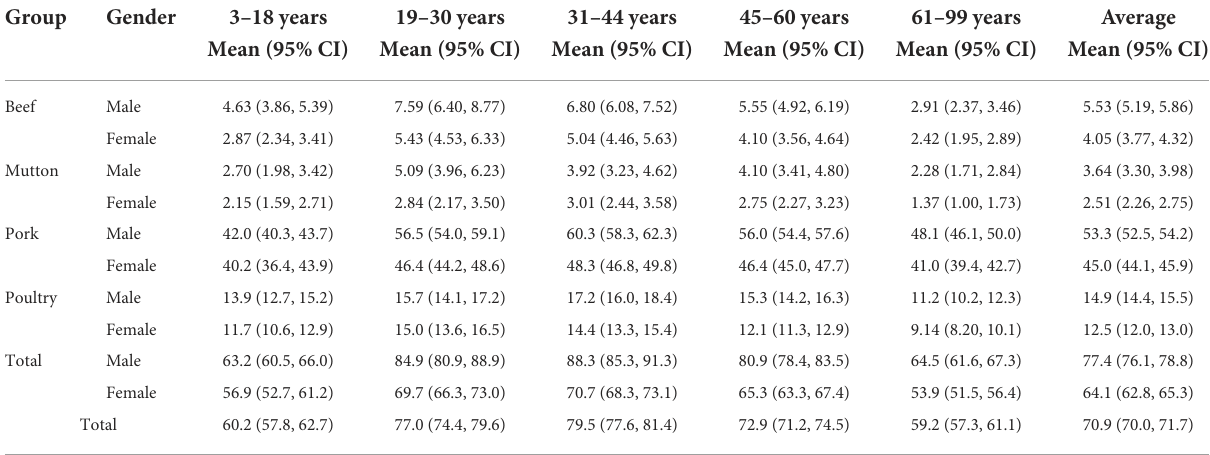
TABLE 3 Daily meat consumption by gender and age groups using 24h recalls (g/d) ( n = 24,106) * .